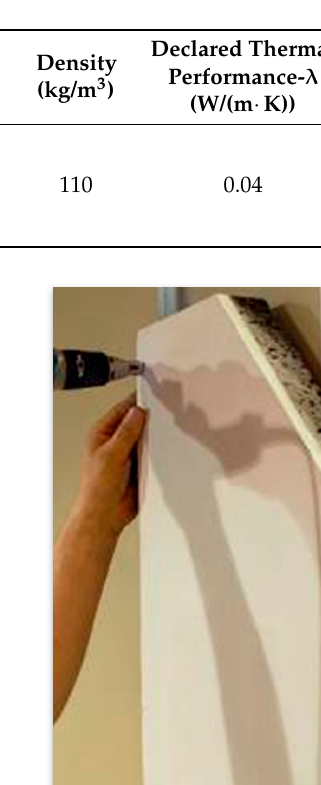
Figure 1. Insulation cork board (ICB) in an External Thermal Insulation Composite System (ETICS) [9]. Table 1. Main technical characteristics of ICB studied in this paper.